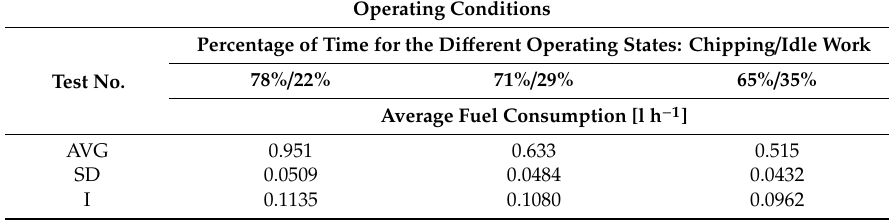
Table 6. The results of fuel consumption of the cylindrical wood chipper with an injector fuel supply system equipped with an adaptative drive control system in periodically-variable exploitation conditions. AVG–arithmetic average, SD–standard deviation of the mean, I–incertitude limits using the Student’s t distribution for a 95% confidence level.